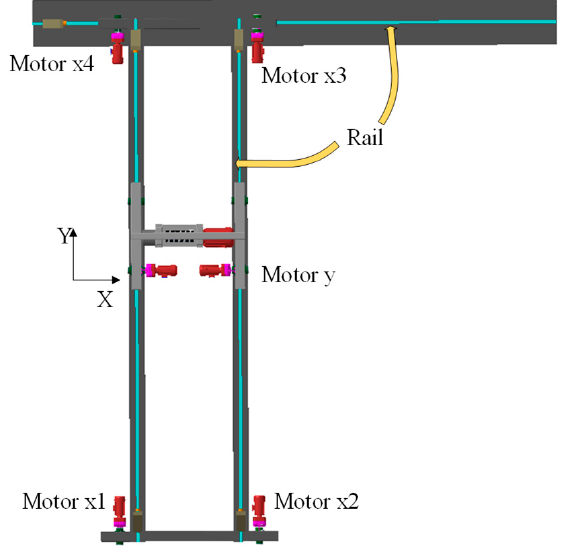
Figure 2. Schematic diagram of the subsystem movement.